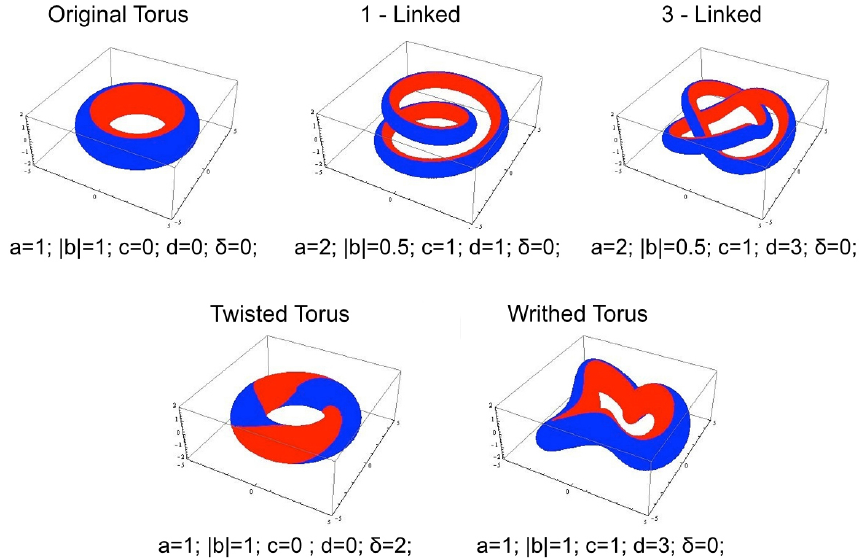
Figure 4. The first solid torus to the left shows the original torus. By changing the parameter d to 1 or 3 we obtain a one- or a three-linked torus. By changing δ from 0 to 2 for the original torus we obtain a twisted torus. Finally by changing the c to 1 and d to 3 for the original torus we obtain a writhed